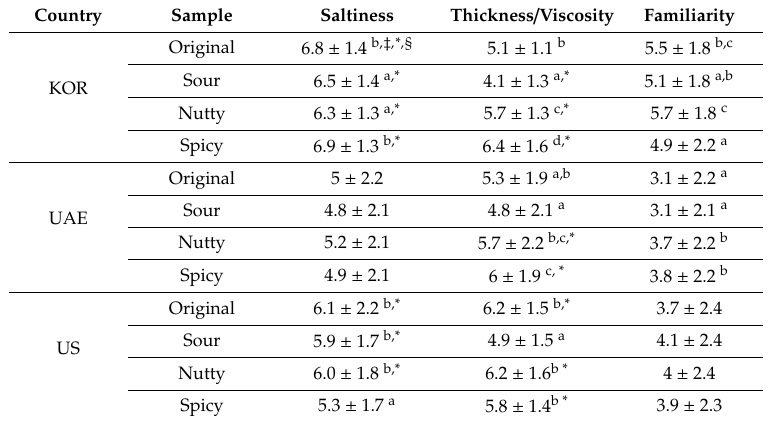
Table 4. Ratings (mean ± SD) of intensities and familiarity of salad dressing samples evaluated by the KOR, UAE, and US † consumers.